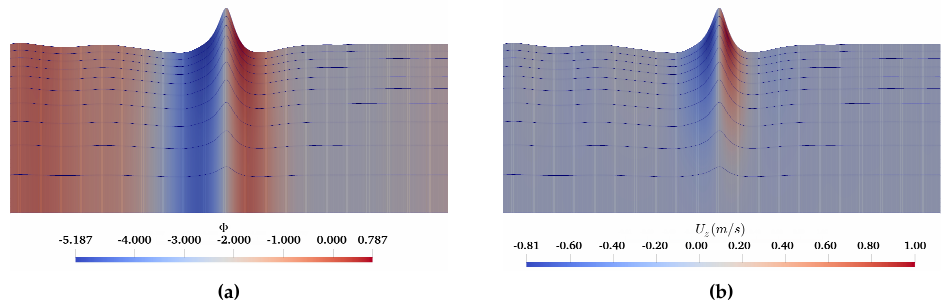
Figure 5. Flow information and σ -grid near the focusing event, (a) velocity potential in the water volume, (b) The vertical velocity component in the water volume.